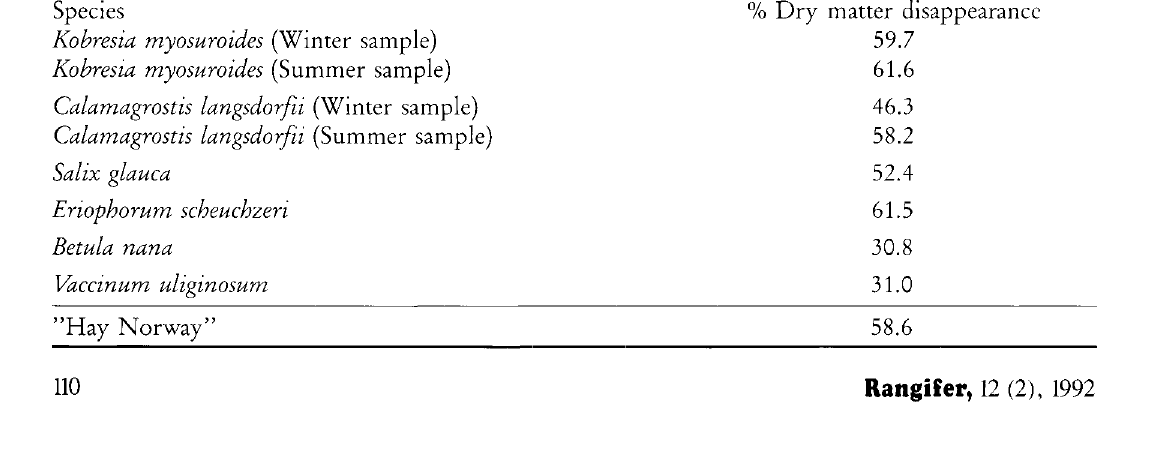
Table 5. In vitro dry matter digestibility of caribou and muskox forage from Greenland. Samples collected in 0rkenda- len August 30. 1990. Rumen liquor from sheep fed a concentrate diet. Included are also 2 winter samples of Kobresia and Calamagrostis collected on May 5.